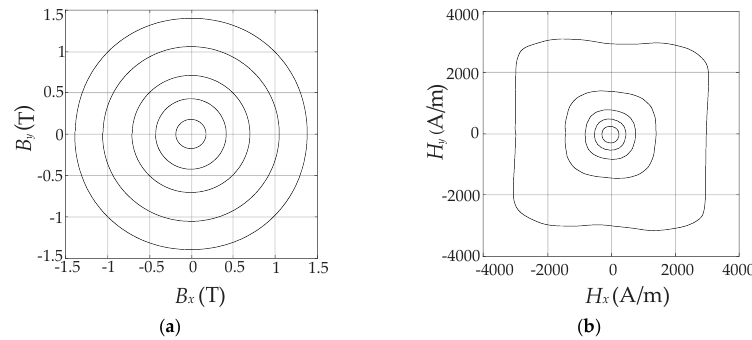
Figure 3. Measured hysteresis curves: ( a ) Locus of vector B ; ( b ) Locus of vector H . The measured concentric hysteresis loops along two orthogonal directions, i.e., x direction and y direction, are shown in Figure 4. The hysteresis curves at the saturated magnetic flux density are the limiting hysteresis loops required for identification of the Preisach model.